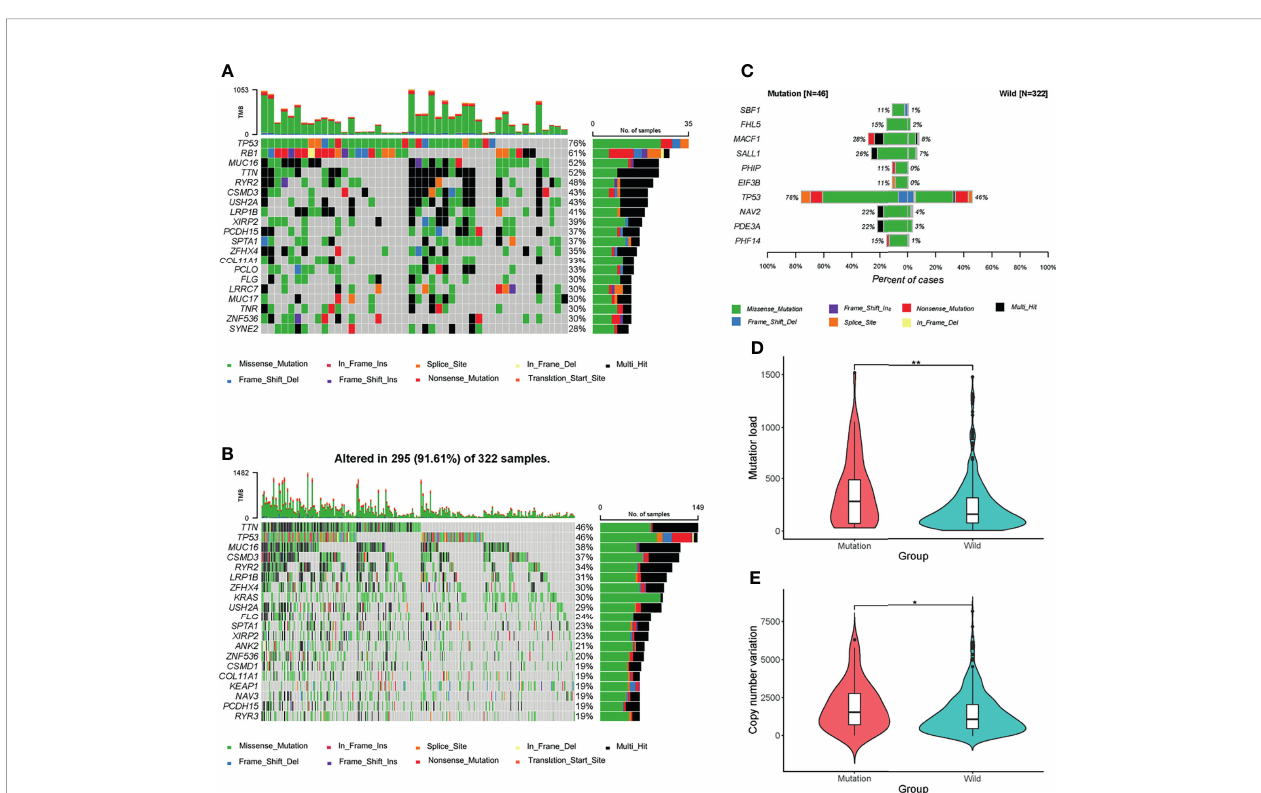
FIGURE 2 | Mutational patterns of the two groups. (A, B) Waterfall maps of the top 20 mutant genes in the mutation and wild groups. (C) Top 10 most signi fi cant differentially muted genes (DMGs) between the mutation and wild groups. Genes including CDKN2A, CCND1, CCNE1, CDK4, and RB1 were excluded. (D, E) Mutation load and copy number variation (CNV) between the two groups. *P < 0.05; **P < 0.01 .